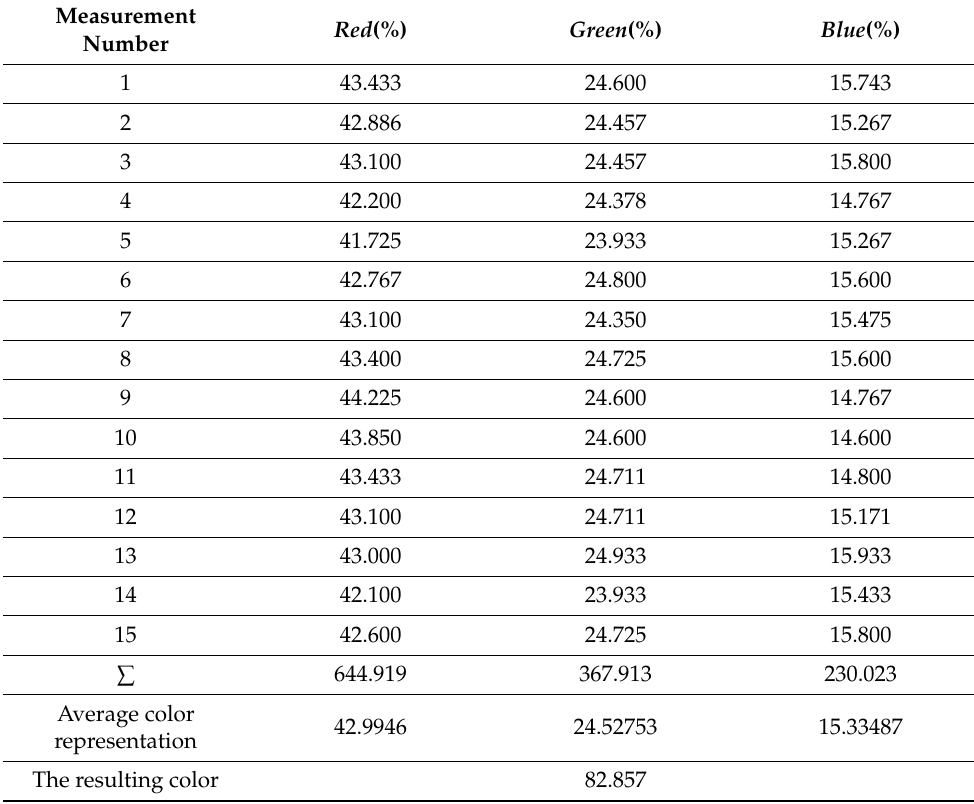
Table 11. Type B uncertainty components.